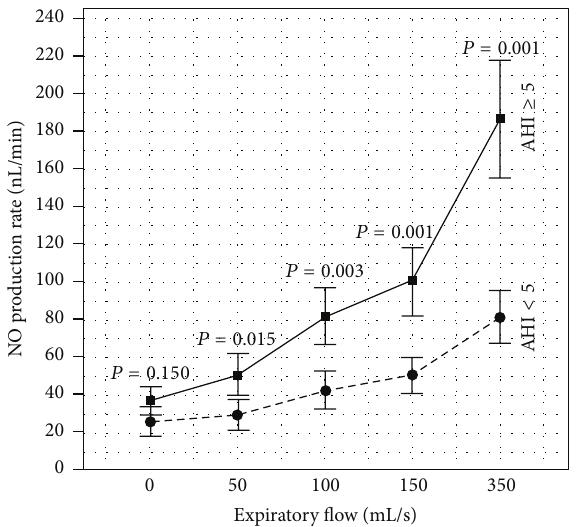
Figure 1: Post-PSG multiflow exhaled NO profile in two AHI groups. Note: the graph represents the mean (95% CI) of post- PSG NO production rate (VNO = FENO × Ex. flow), measured at 4 different levels of expiratory flow (50, 100, 150, and 350 mL/s). The J’awNO and CANO can be determined using the simple linear approach by Tsoukias and George [13]: VNO = J’awNO + CANO × Ex. flow. 𝑃 value: significance of difference between healthy subjects (AHI < 5, circle point and dotted line) and patients with OSA (AHI ≥ 5, square point and continuous line).